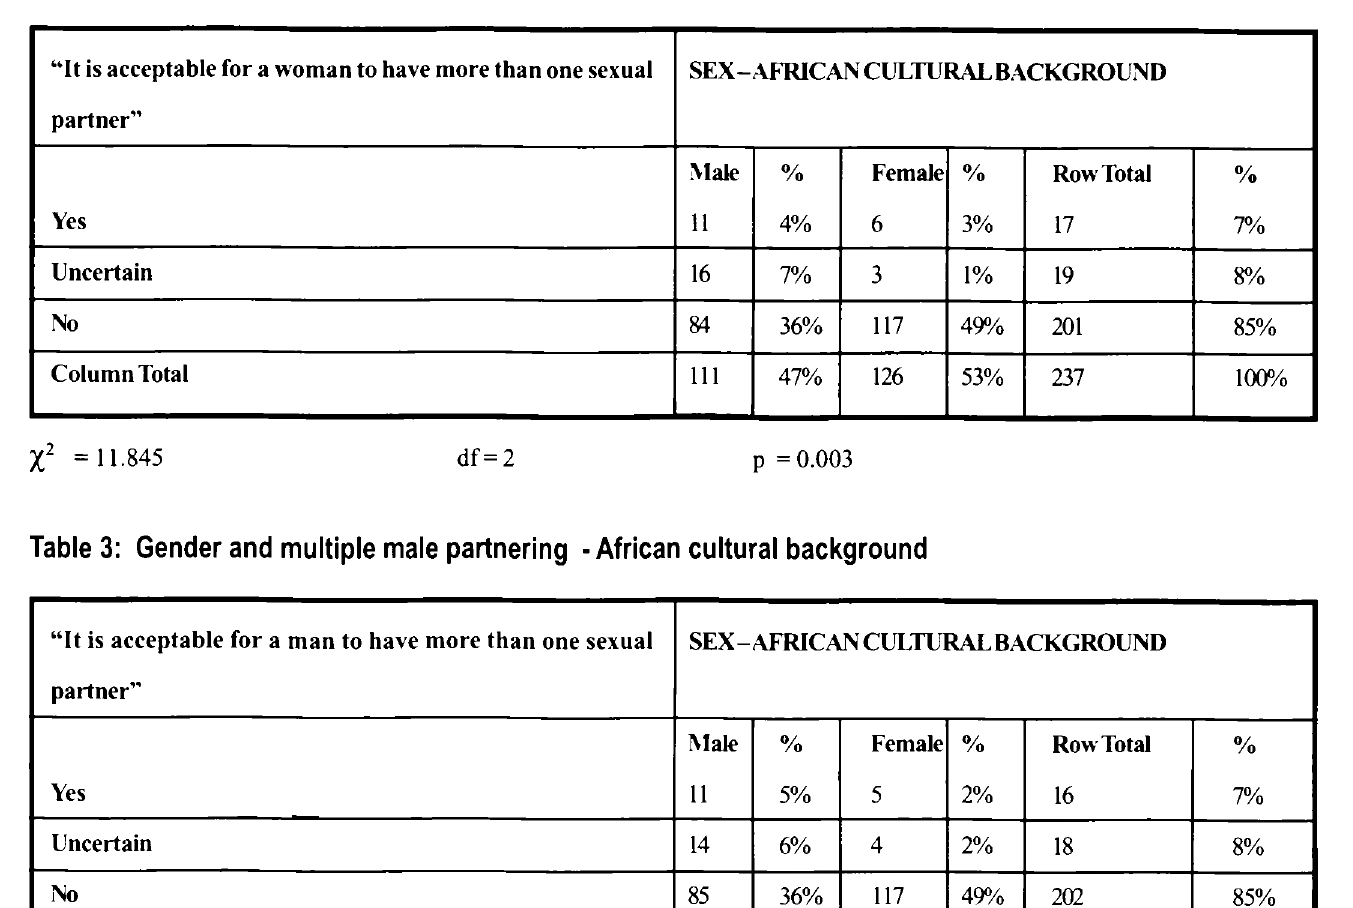
Table 3: Gender and multiple male partnering - African cultural background “It is acceptable for a man to have more than one sexual partner'”